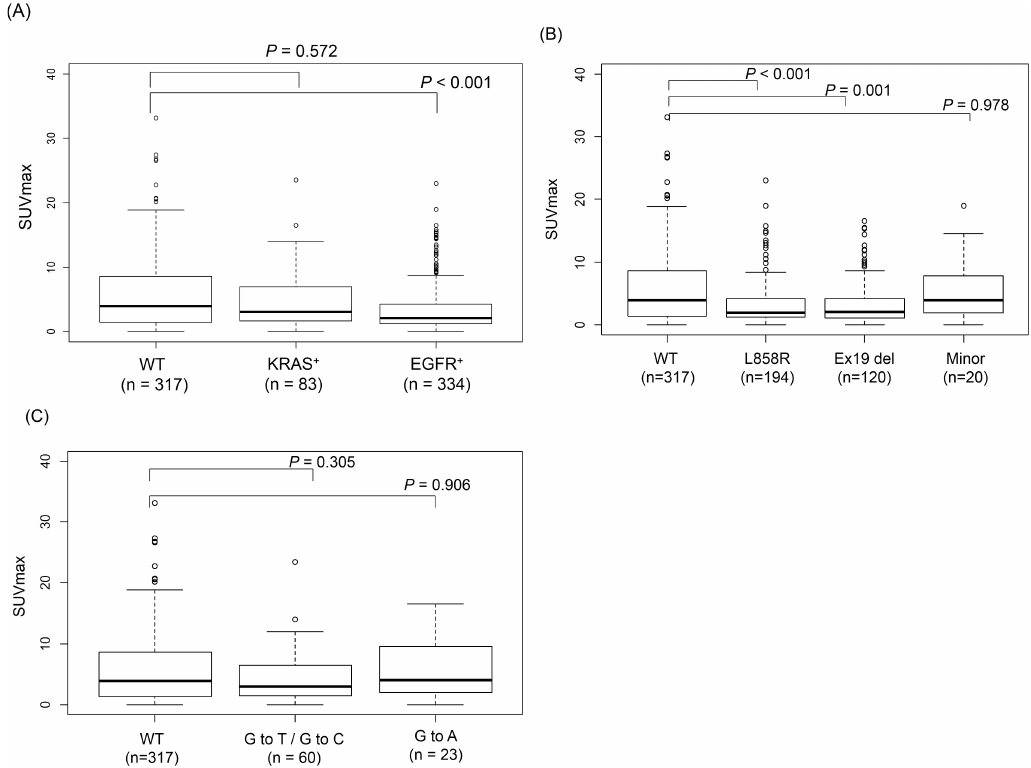
Fig 1. Correlations between SUV max of primary tumors and EGFR and KRAS mutation status. (A) Box plot of SUV max of primary tumors accordingto EGFR and KRAS mutation status, (B) Box plot of SUV max of primary tumors accordingto EGFR mutation spectra, (C) Box plot of SUV max of primary tumors accordingto KRAS mutation spectra.